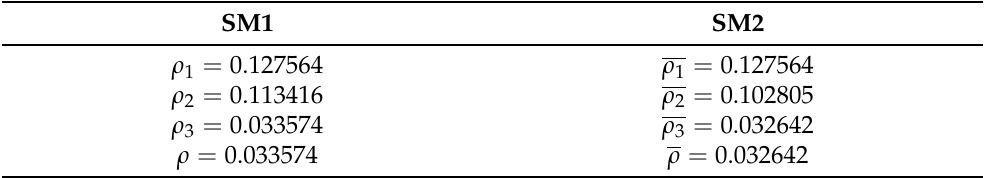
Table 2. Comparison of convergence radii for Example 2.